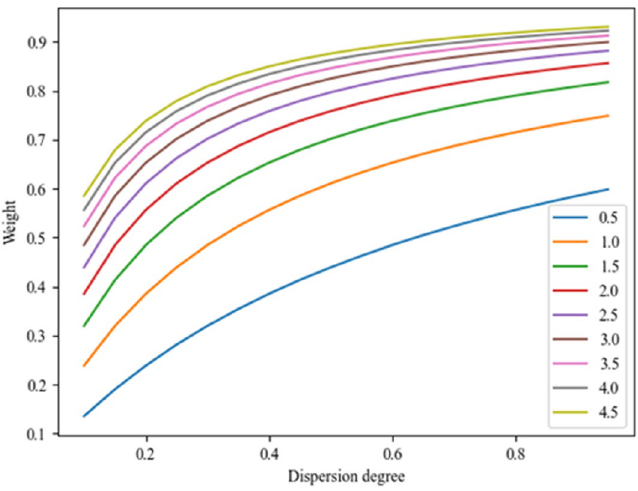
Figure 5. The impact of dispersion degree on weight at different conflict degree levels.